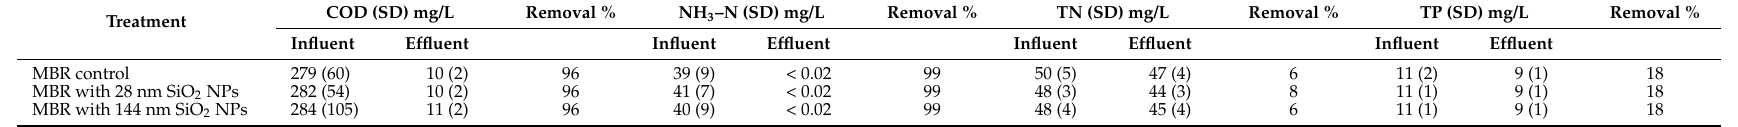
Table 1. Summary of the performance of MBR with and without exposure to SiO 2